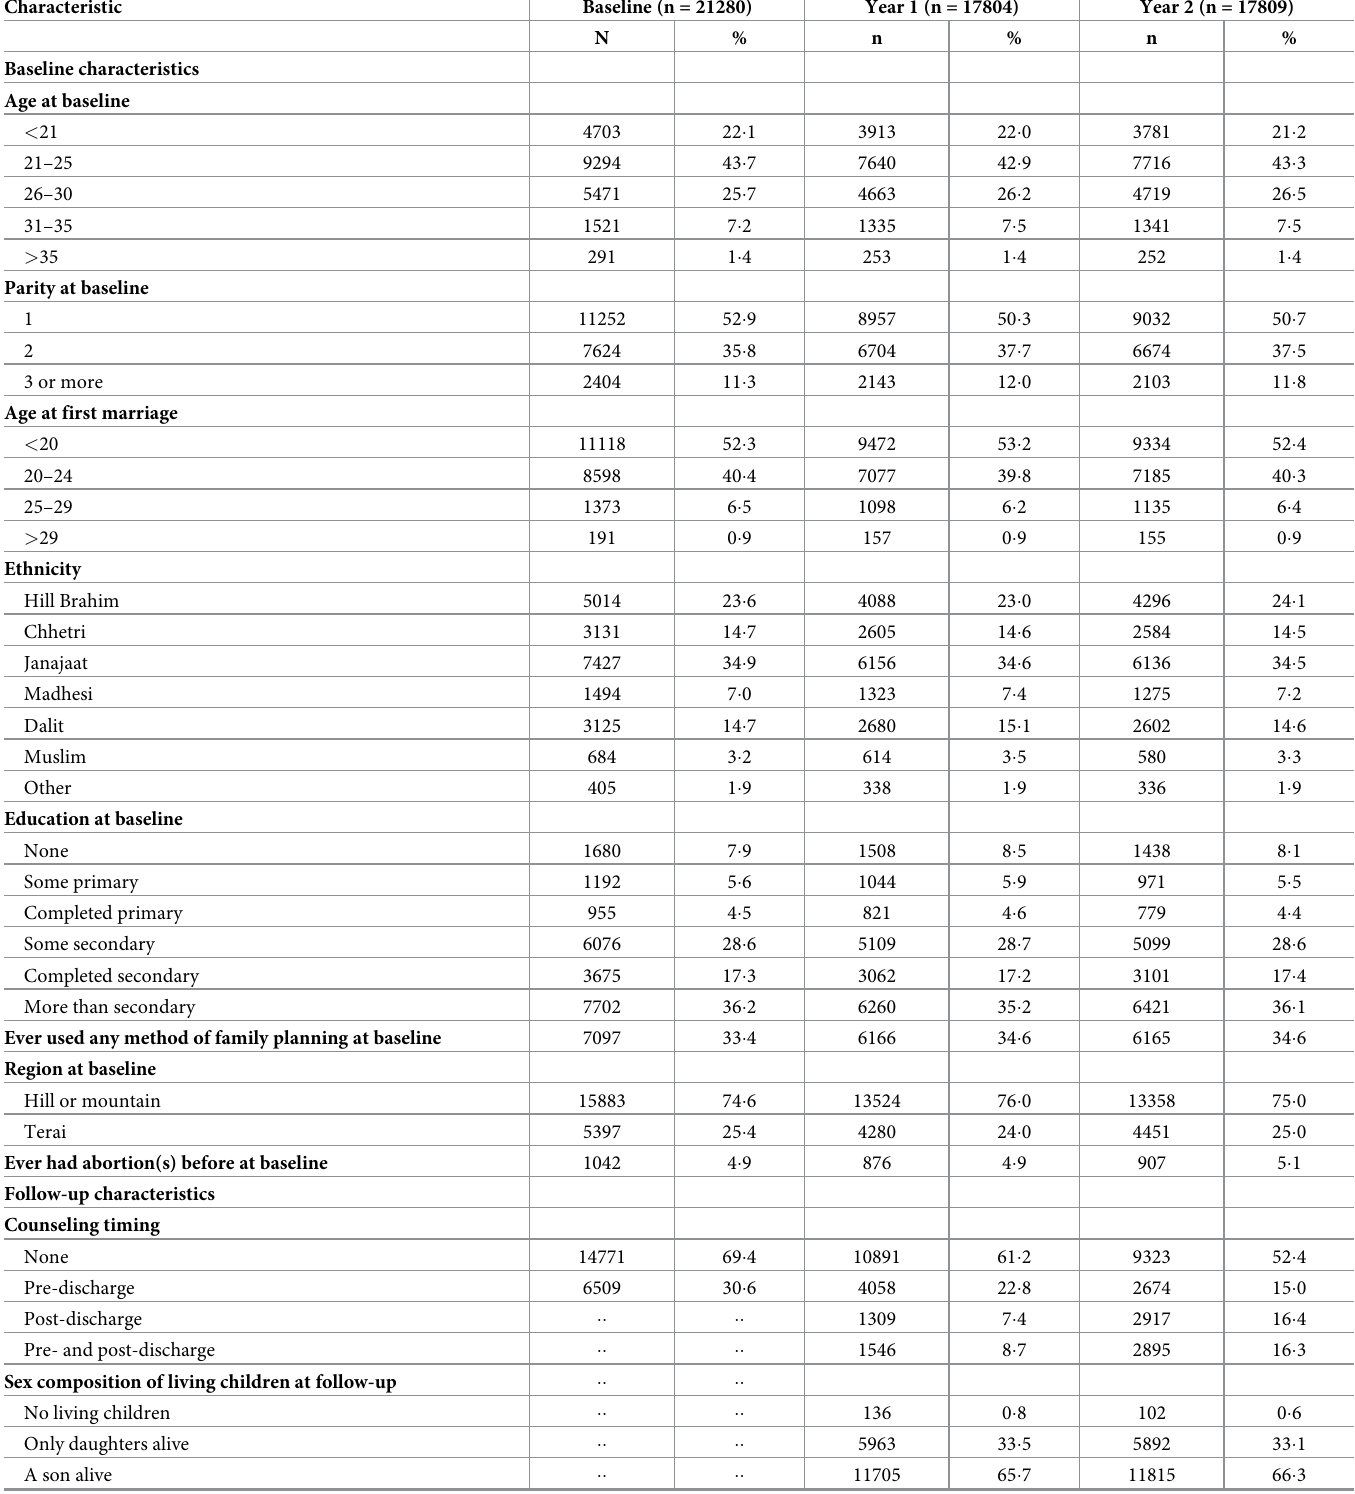
Table 1. Participant background characteristics, number and percentage of baseline, year one, and year two samples.